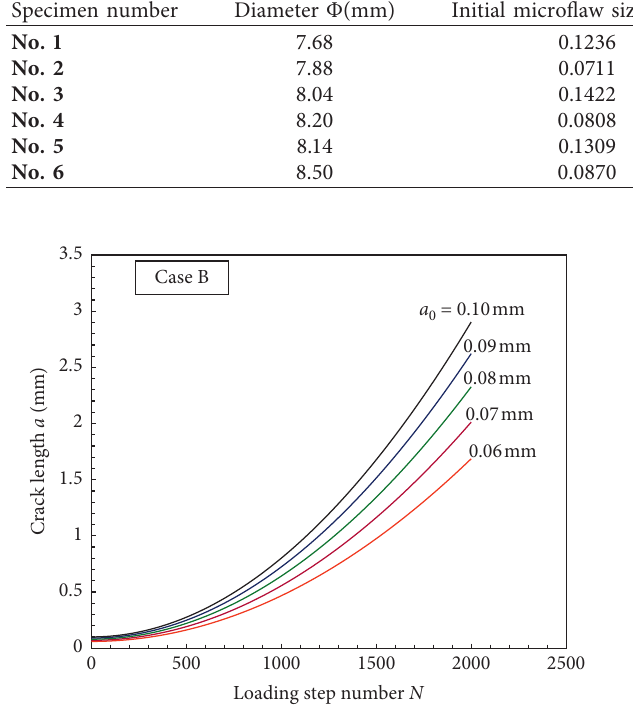
Figure 12: Crack length a versus loading step number N curves for different initial microflaw sizes a 0 .